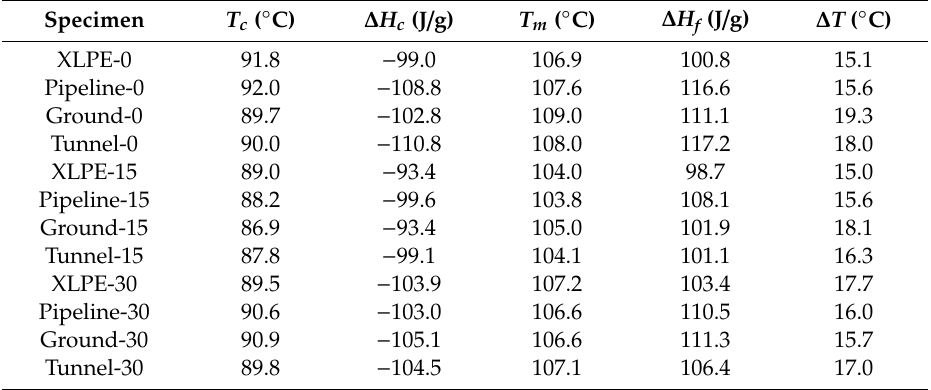
Table 4. Parameters obtained from first cooling and second heating